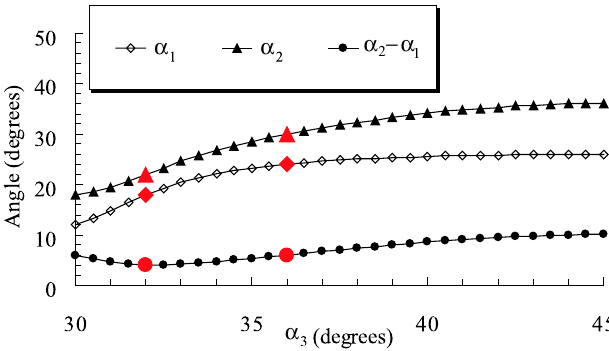
FIG. 29. (Color) Functions defined in (B5), (B8), and (B9) versus cable width w for an aperture radius of 30